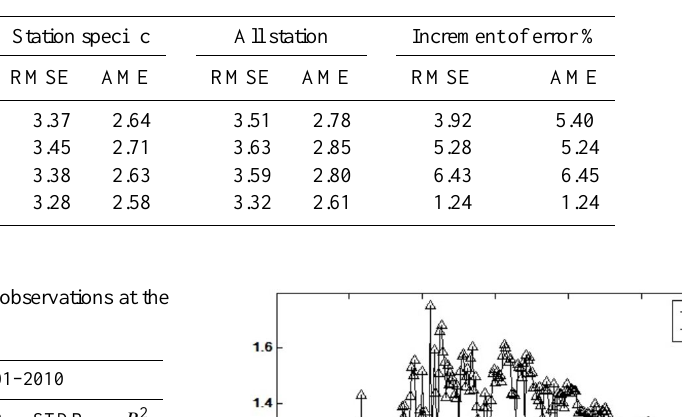
Table 6. RMSE and AME errors and their relative increment of T a estimation (2001–2010) using station-specific linear regressions respec- tively a single linear regression.